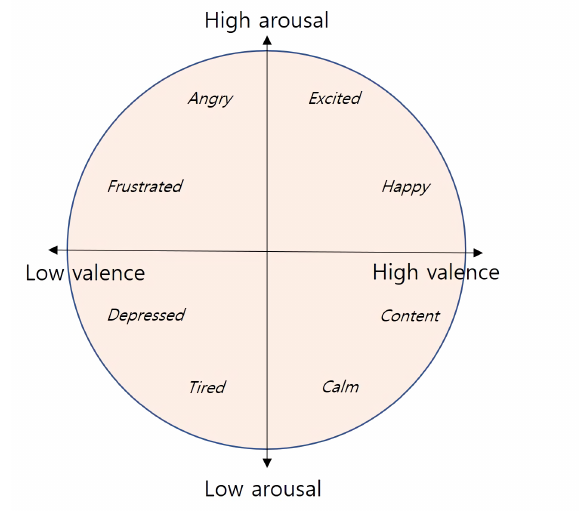
Figure 1. Arousal valence emotion